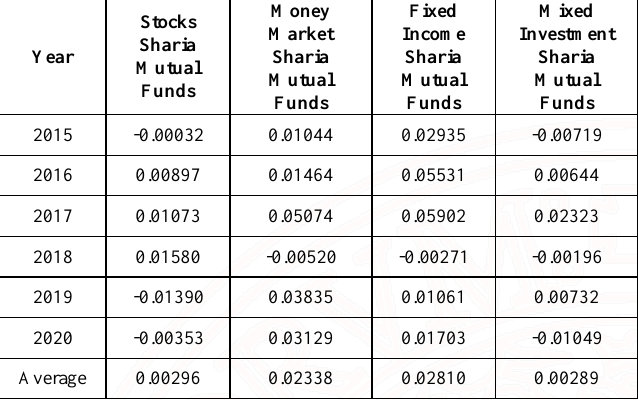
TABLE 1. THE AVERAGE RETURN RATIO OF SHARIA MUTUAL FUNDS